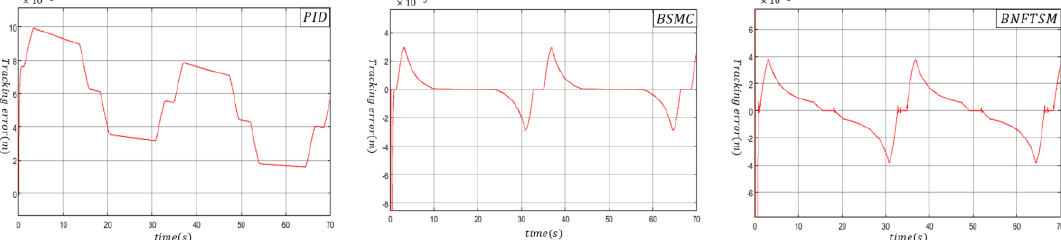
Figure 3. Tracking error curves of three controllers without load force.